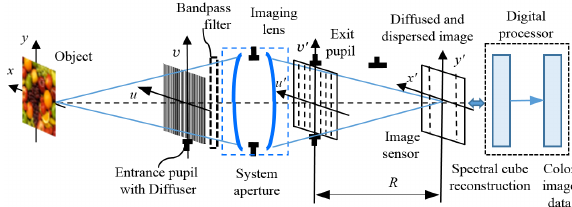
Figure 1. Optical scheme of a spectral and color imaging optical system based on a digital camera and a diffuser.